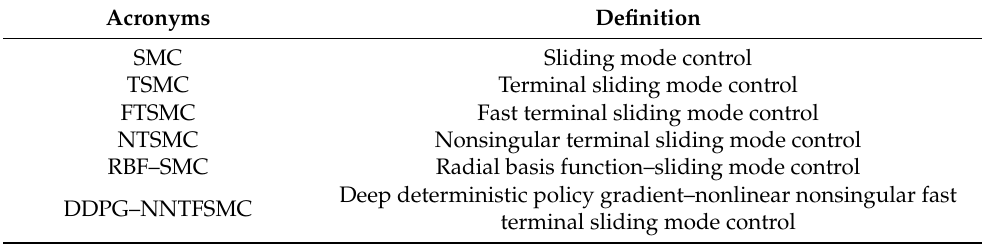
Table 1. Definition of